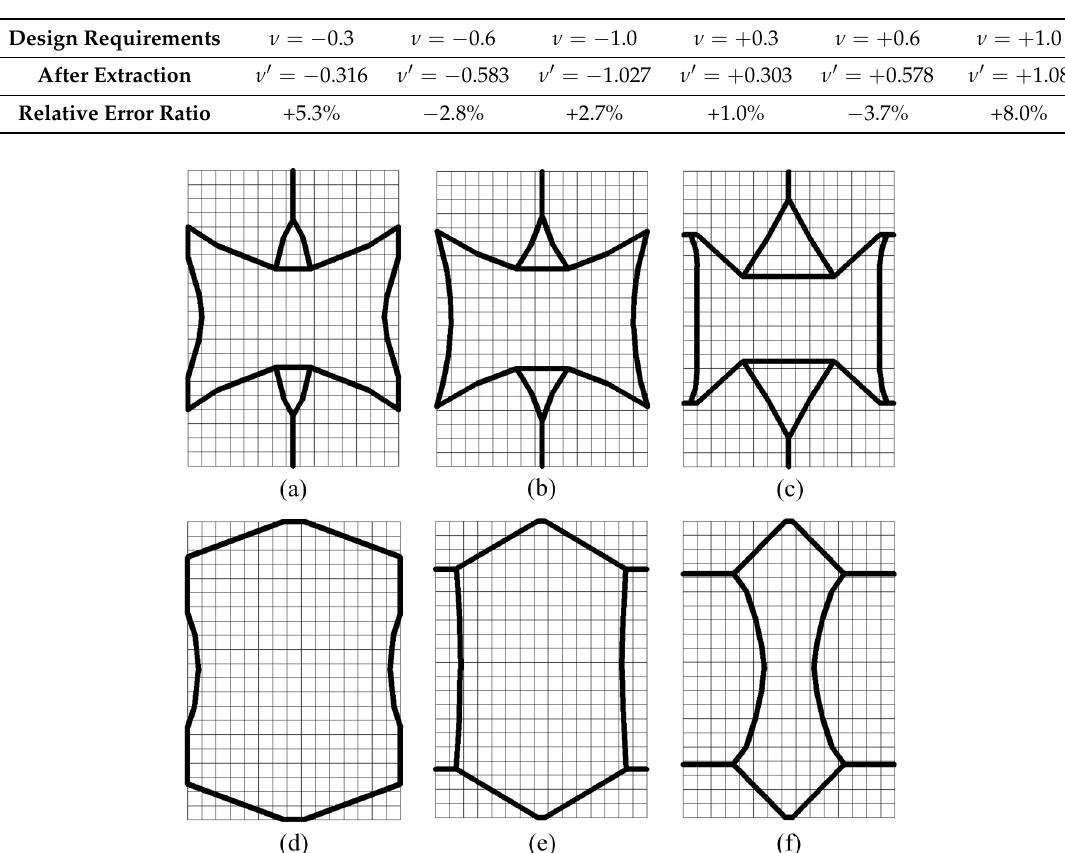
Figure 4. Extraction of optimal configurations corresponding to various PR values: ( a ) 𝜈 = −0.3 ; ( b ) 𝜈 = −0.6 ; ( c ) 𝜈 = −1.0 ; ( d ) 𝜈 = +0.3 ; ( e ) 𝜈 = +0.6 ; ( f ) 𝜈 = +1.0 .